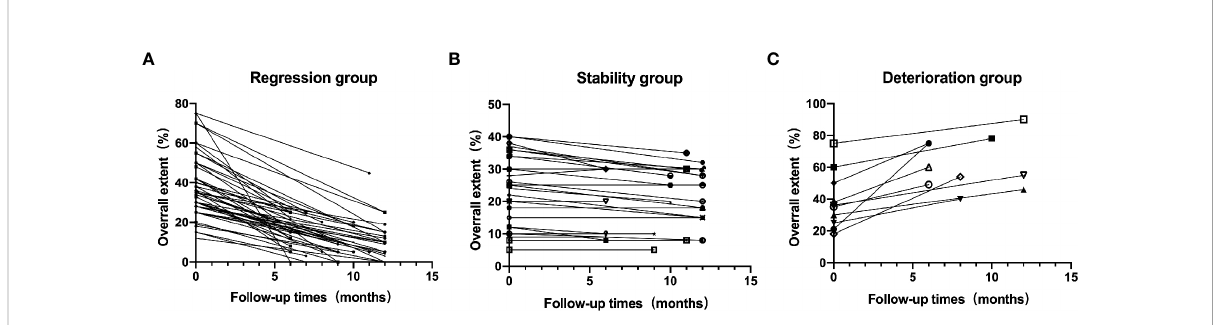
FIGURE 1 Changes in the overall extent of lung parenchymal abnormalities during follow-up between Regression group (A) , Stability group (B) and Deterioration group (C)